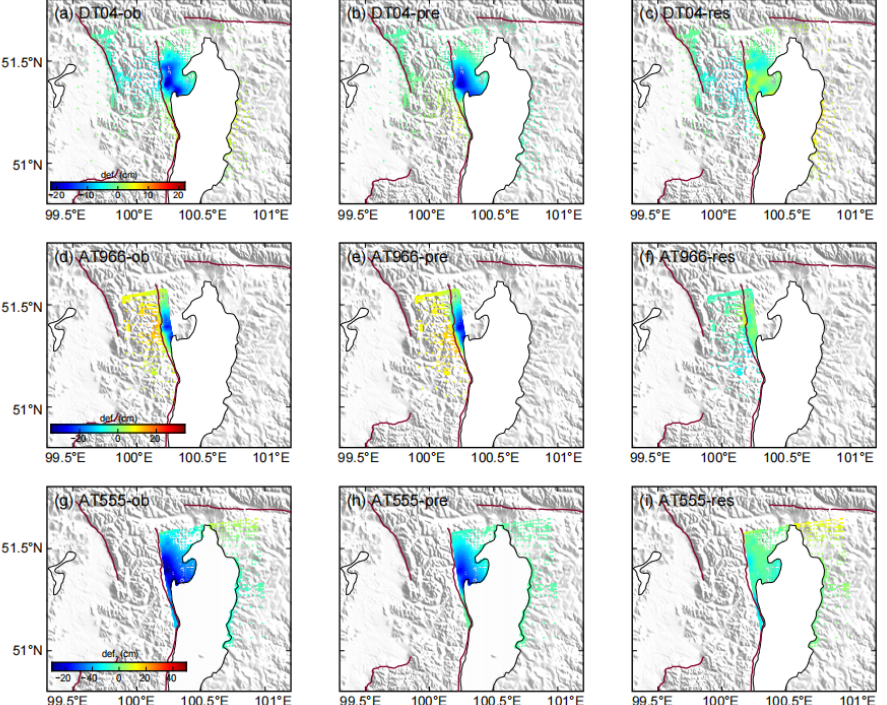
Figure 4. Observed ( a , d , g ), predicted ( b , e , h ), and residual ( c , f , i ) maps based on our preferred model of tracks DT04, AT966, and AT555, respectively.